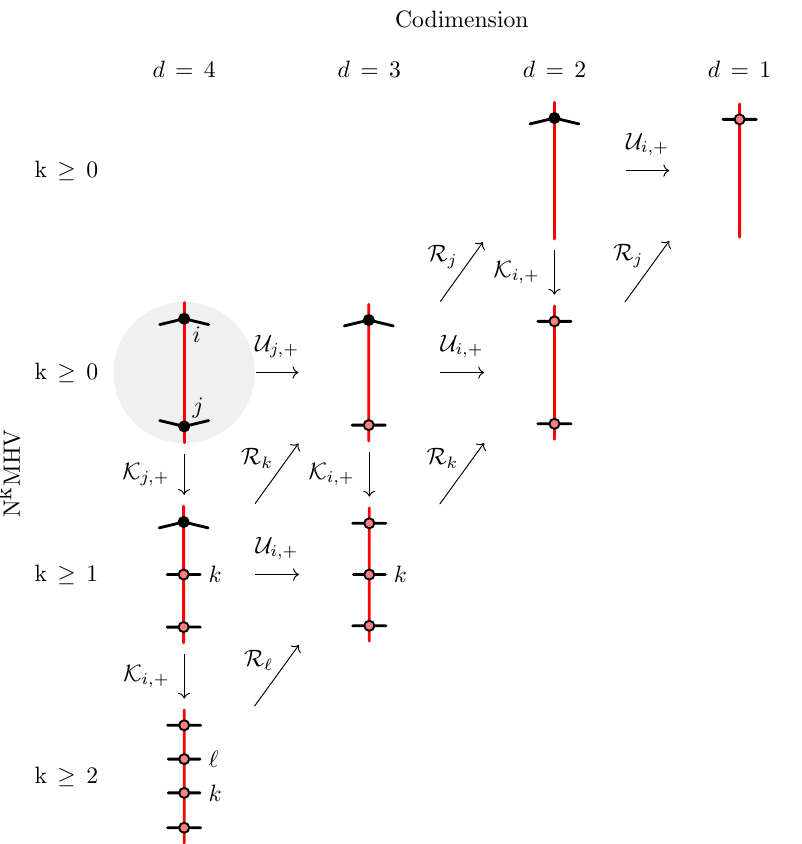
Figure 2. Twistor diagrams depicting eight types of low-k boundaries of N k MHV amplituhedra, organized according to the minimum value of k and the codimension d (equivalently, the number of on-shell conditions satis(cid:12)ed). These correspond respectively to branch types (2), (1), (12), (7), (4), (16), (9) and (18)/(19). The graph operators K , R , and U are explained in the text and demonstrated in (cid:12)gures 3{5, respectively. Evidently all eight types of boundaries can be generated by acting with sequences of these operators on MHV maximal codimension boundaries of the type shown shaded in gray. There is an analogous parity-conjugated version of this hierarchy which relates all of the high-k branches to each other. The missing low-k boundary types (5), (6), (10), (11), (14) and (15) are degenerate cases which can be obtained by starting with j = i + 1 in the gray